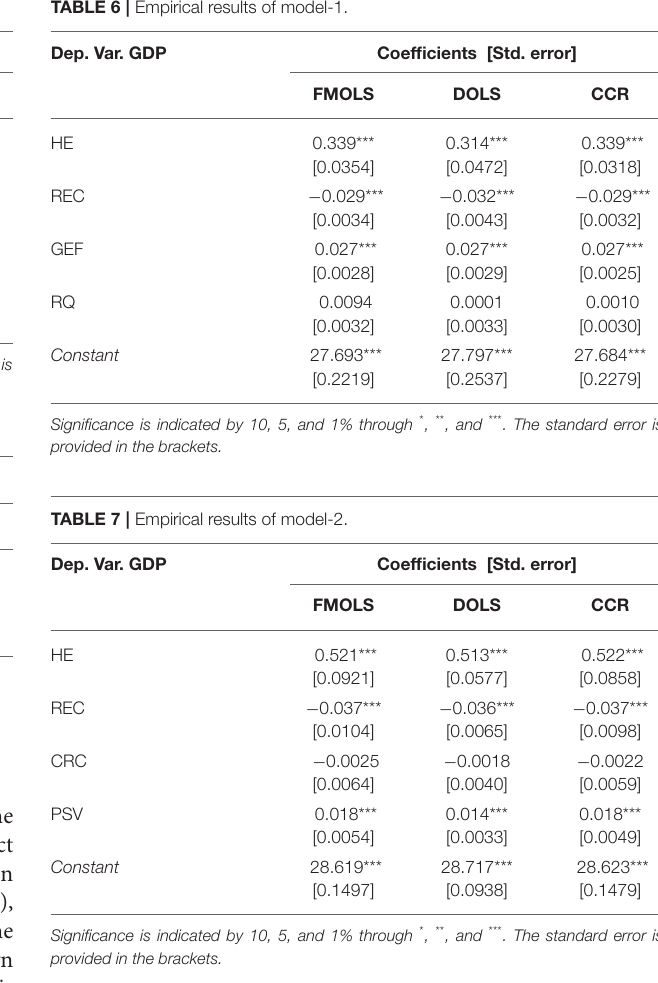
TABLE 4 | Unit root testing.